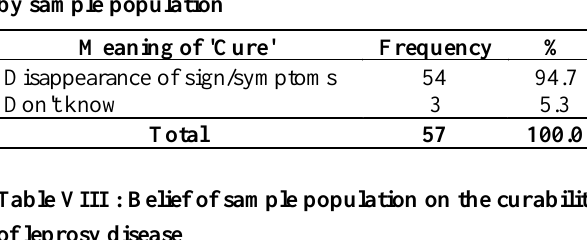
Table VII : Meaning of 'Cure of the disease' as believed